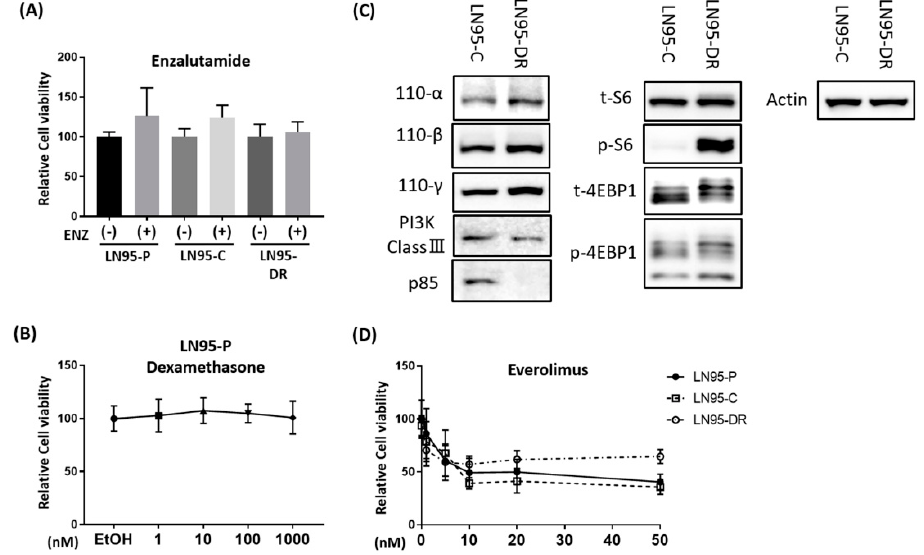
Figure A1. Effect of enzalutamide, dexamethasone, or everolimus on taxane-resistant cells. ( A ) Resistance of LN95-P, LN95-C, and LN95-DR cell viability to 10 µM enzalutamide for 72 h; ( B ) Dose response of dexamethasone on the growth and viability of LN95-P cells; ( C ) Levels of proteins related to the PI3K/Akt/mTOR axis in whole cell lysates; ( D ) Dose response of everolimus on the viability of LN95-P, LN95-C, and LN95-DR cells.